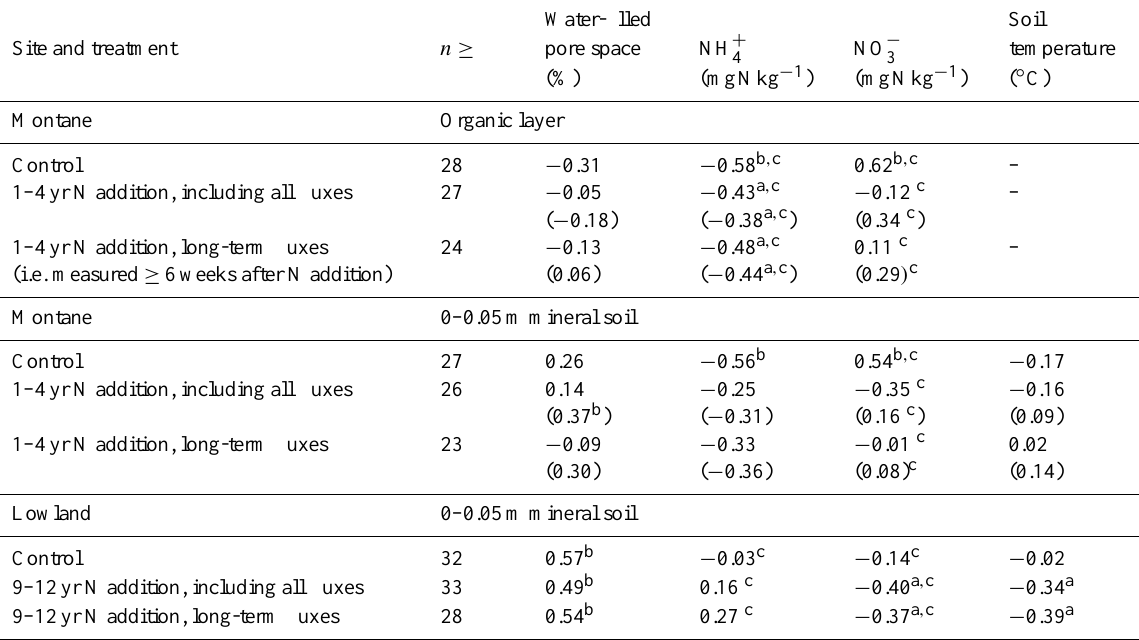
Table 2. Pearson correlation coefficients between soil CH 4 -C fluxes (µgCm − 2 h − 1 ) and soil variables, using the mean values of each treatment on each sampling day, measured from 2006 to 2009. For the montane forest N-addition plots, coefficients in parentheses are from analyses that include the few events of large CH 4 emissions (please see Sect. 2.5). Water-filled Soil Site and